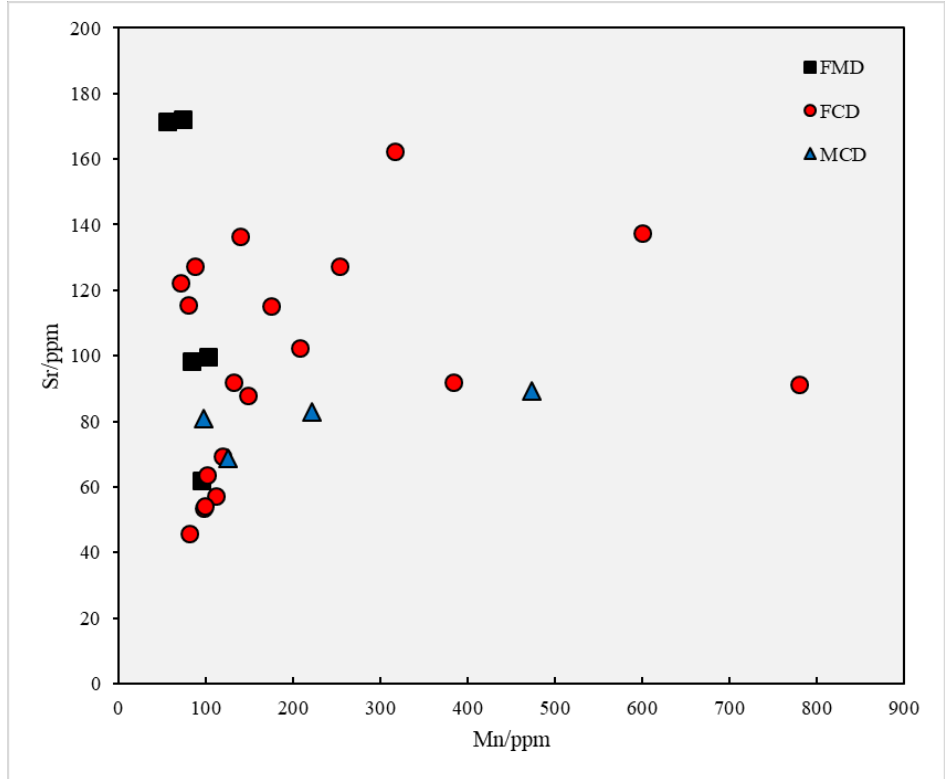
Figure 5. Cross-plot of Mn and Sr values for dolomites. FMD: Fine-microcrystalline dolomite; FCD: Fine crystalline dolomite; MCD: Medium crystalline dolomite.